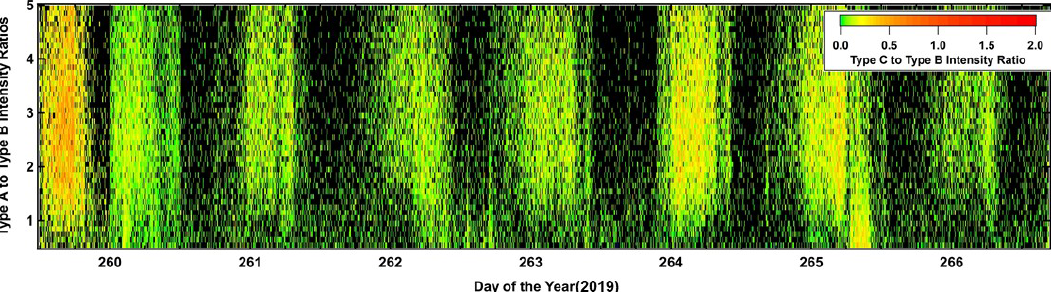
Figure 8. Temporal distribution of the emission wavelength dependence (type A to type B) versus excitation wavelength dependence (type C to type